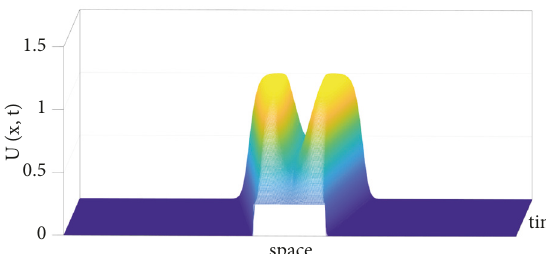
Figure1:Numericalsolutioninthecaseofonespacedimensionand unbounded domain.